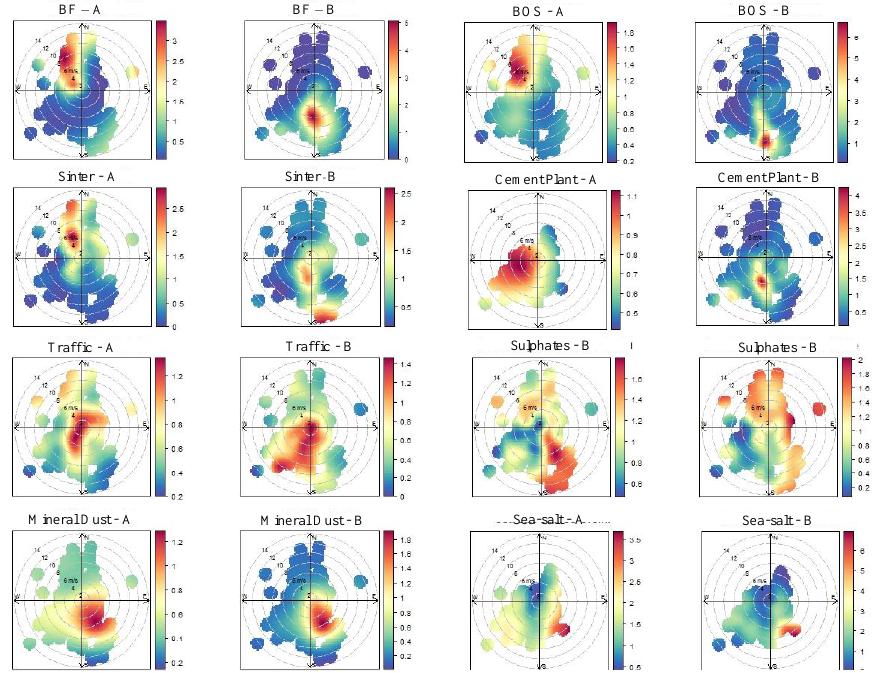
Figure 9. Source polar plots as a function of wind direction and speed in site A and site B for the 8 sources identified in the fine fraction.